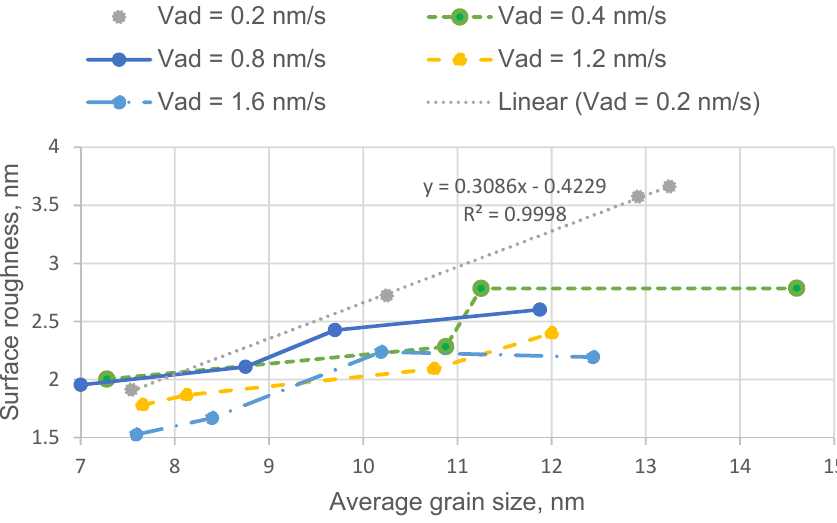
Figure 9. Plots of surface roughness versus average grain size observed at the growth rates of 0.2, 0.4, 0.8, 1.2, and 1.6 nm/s.